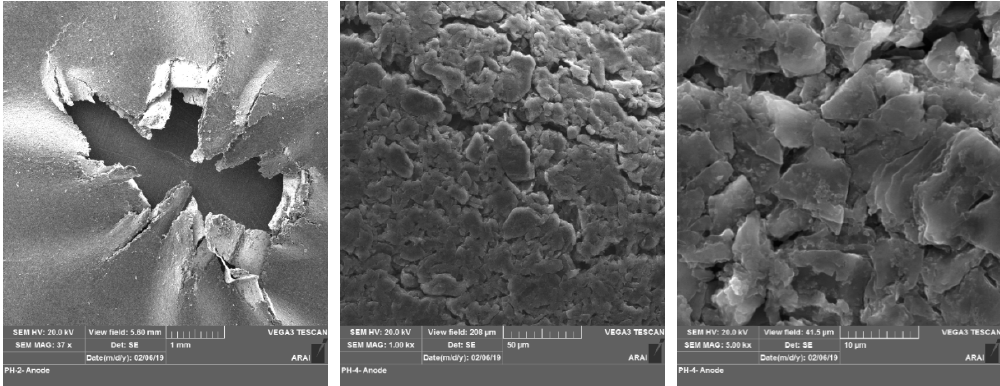
Figure 7. Nail-penetrated cell anode with location at centre (50% SoC).